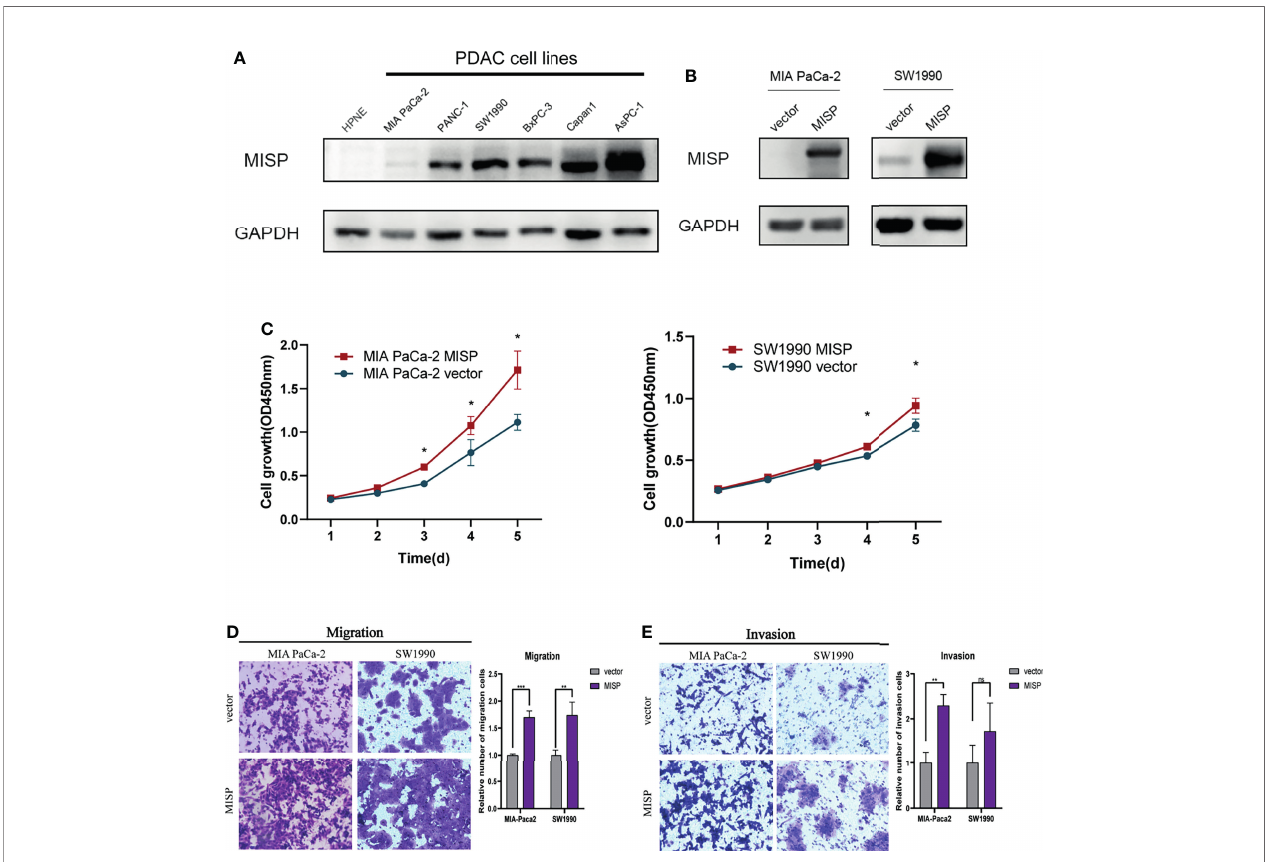
FIGURE 3 | The effects of MISP expression on PDAC cell proliferation, migration, and invasion. (A) MISP protein expression levels were detected in hTERT-HPNE and several PDAC cell lines. GAPDH was used as the loading control. (B) The overexpression ef fi ciency of MISP was measured by western blotting. (C) CCK-8 assays demonstrated that the overexpression of MISP promoted the proliferation of MIA PaCa-2 and SW1990. *P<0.05. (D, E) Transwell migration and invasion assays. MISP-overexpressed MIA PaCa-2 and SW1990 exhibits signi fi cantly increased migration and invasion capacity than the negative controlled infectants, exclusive of the invasion capacity of SW1990 cells. *P < 0.05; **P < 0.01; ***P < 0.001; ns, not signi fi